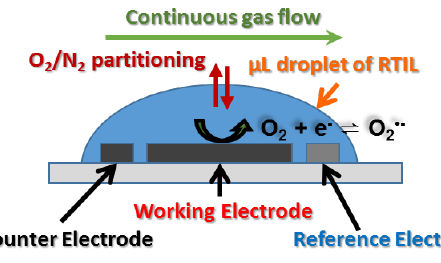
Figure 1. Illustration (not to scale) of the side-view of a microliter droplet of RTIL covering the working, counter, and reference electrodes of a screen-printed electrode device.